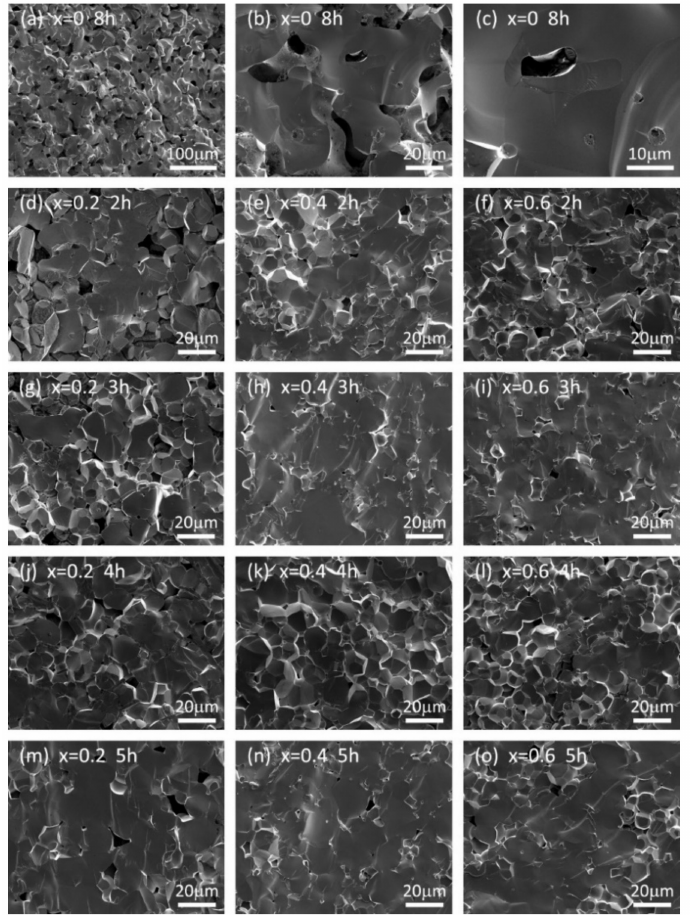
Figure 4. Cross-section SEM images of LLZN x O (x = 0, 0.2, 0.4, 0.6) ceramics sintered at 1250 ◦ C for different holding times. ( a – c ): x = 0, 8 h at different magnification. ( d – f ): x = 0.2, 0.4, 0.6 sintered for 2 h respectively. ( g – i ): x = 0.2, 0.4, 0.6 sintered for 3 h respectively. ( j – l ): x = 0.2, 0.4, 0.6 sintered for 4 h respectively. ( m – o ): x = 0.2, 0.4, 0.6 sintered for 5 h